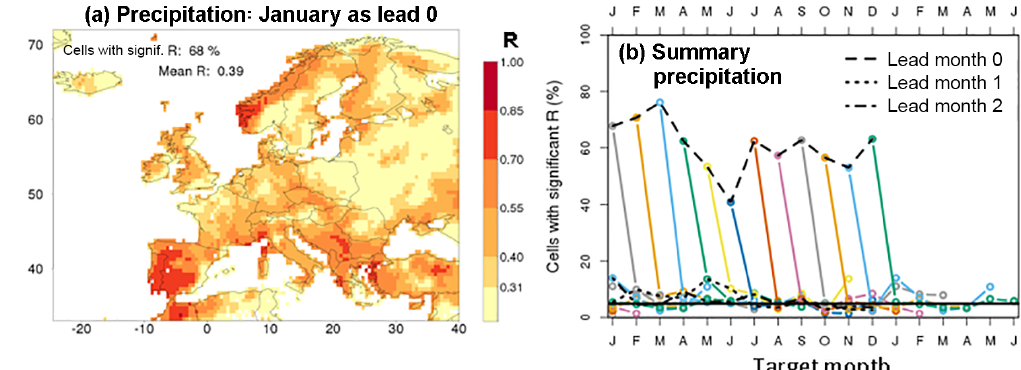
Figure 1. Skill of the precipitation hindcasts after bias correction. Figure 1a shows a map of the correlation coefficient between the observa- tions and the median of the hindcasts ( R ), for target month January as lead month 0. The threshold of significant skill lies at 0.31, so cells with the lightest yellow colour have insignificant skill, and grid cells with other colours have significant skill. The legend provides the percentage of cells with significant values of R and the domain-averaged value of R . Figure 1b depicts the percentage of cells with significant skill in terms of R as a function of the target and lead month. Each coloured curve represents the hindcasts starting in a single month of the year and has a length of 7 (lead) months. For better visualisation the parts of the curves that end in the next year are shown twice, namely at the left-hand and the right-hand side of the graph. Black lines connect the results for identical lead times, which are specified in the legend (lead m = lead month). The horizontal line gives the expected fraction of cells with significant skill due to chance in the case that the hindcasts have no skill at all